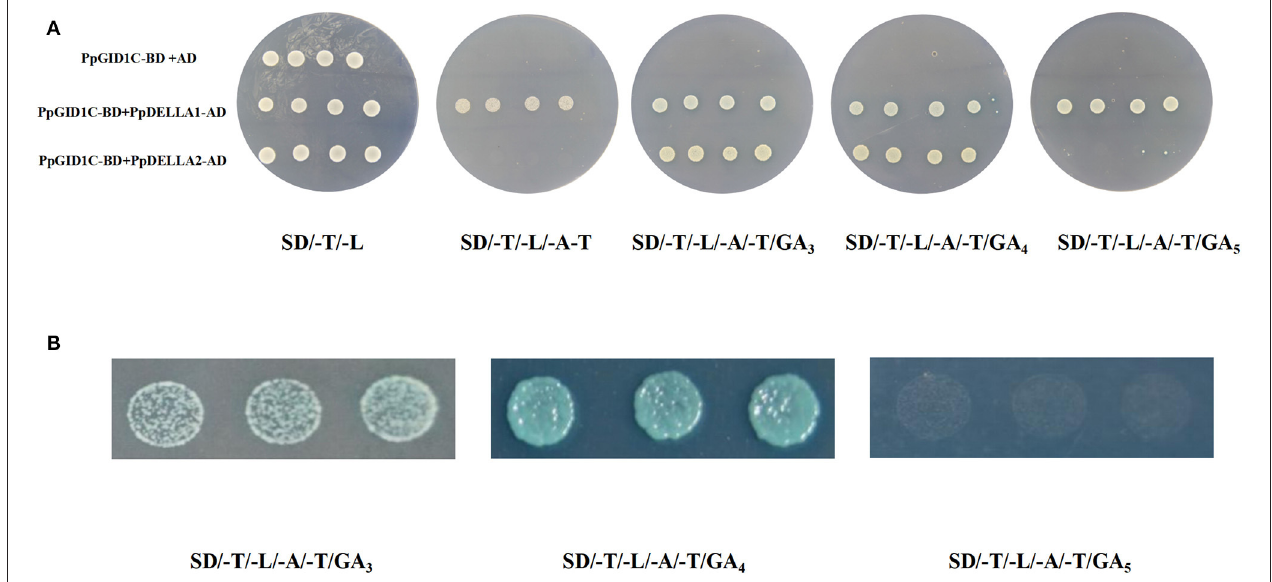
FIGURE 5 | Interaction between PpGID1c and PpDELLA1/2. (A) The Y2H-Gold yeast strain was co-transformed with the bait and prey to SD/-Leu/-Trp and SD/-Leu/-Trp/-His/-Ade/GA medium. Yeast cells transformed with AD + BD-PpGID1c were included as negative controls. (B) Co-transformed the PpGID1c-BD and PpDELLA2-AD yeast strain in the first 48h of SD/-Leu/-Trp/-His/-Ade/GA